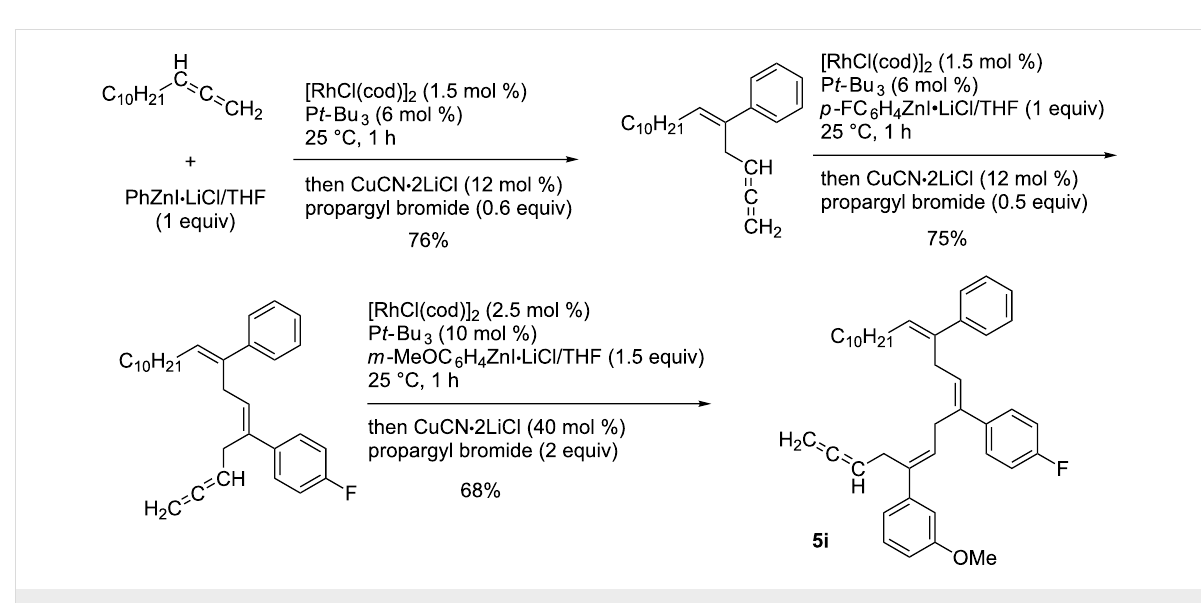
Scheme 50: Synthesis of skipped polyenes by iterative arylzincation/allenylation reaction.